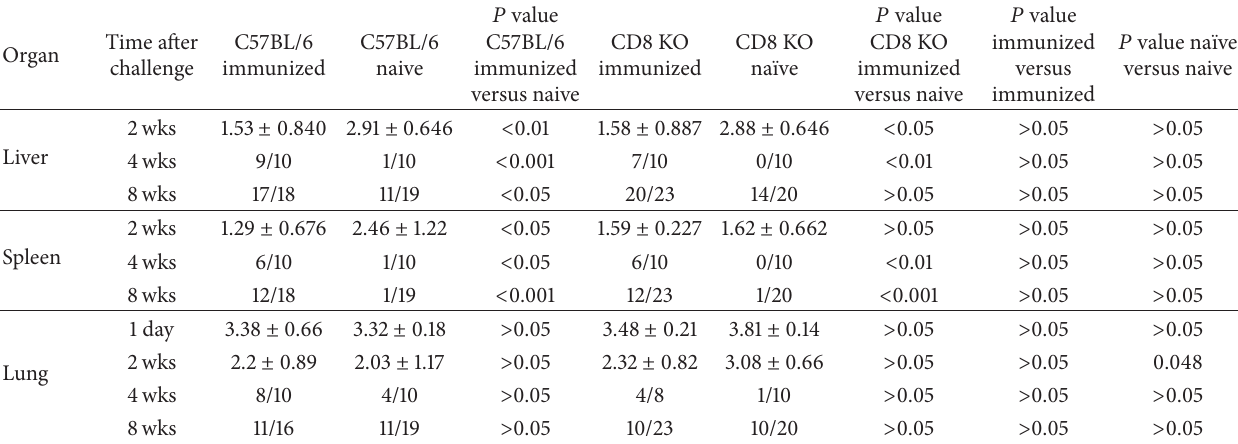
Table 1: Six-week-old male C57BL/6 and CD8 knockout (CD8 KO) mice were orally immunized with 10 11 WR201 and eight weeks later challenged with 10 4 B. melitensis 16M. Figures at 1 day and 2 weeks after challenge, when most or all animals were infected, are mean CFU ± SD. At 4 and 8 weeks, when many animals had cleared the infection and mean CFU counts became less meaningful, figures are shown as ratio of cleared/total. At day 1, 𝑛 = 5 for C57BL/6 and 𝑛 = 4 for CD8 KO; at 2 weeks 𝑛 = 10 for all groups. CFU comparisons utilized Student’s 𝑡 -test while clearance comparisons utilized Fisher’s exact